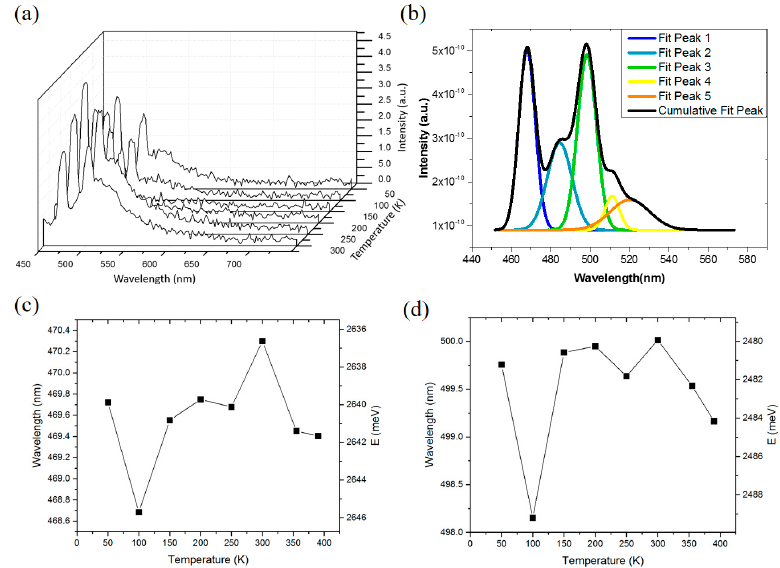
Figure 3. ( a ) The temperature dependent photoluminescence (PL) spectra from 50 to 300 K; ( b ) The PL spectrum of a grown QD/QW wafer at temperature 20 K, and the decomposed sub peaks from the PL spectrum by using a software Origin 8.1; ( c ) the PL peak 1 spectra of the cool white QD LEDs with varied temperature from 50 to 400 K; ( d ) the PL peak 3 spectra of the cool white QD LEDs with varied temperature from 50 to 400